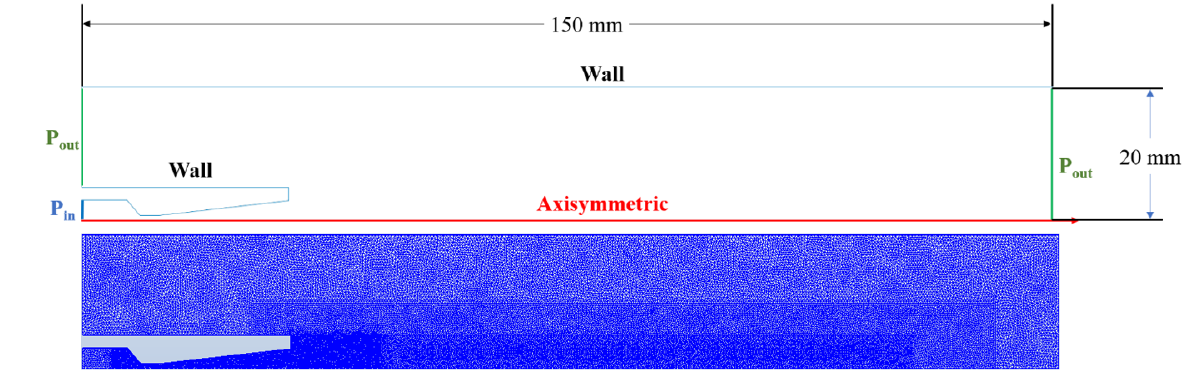
Figure 4. Mesh study. Average cavitation vapor volume fraction at the nozzle exit.